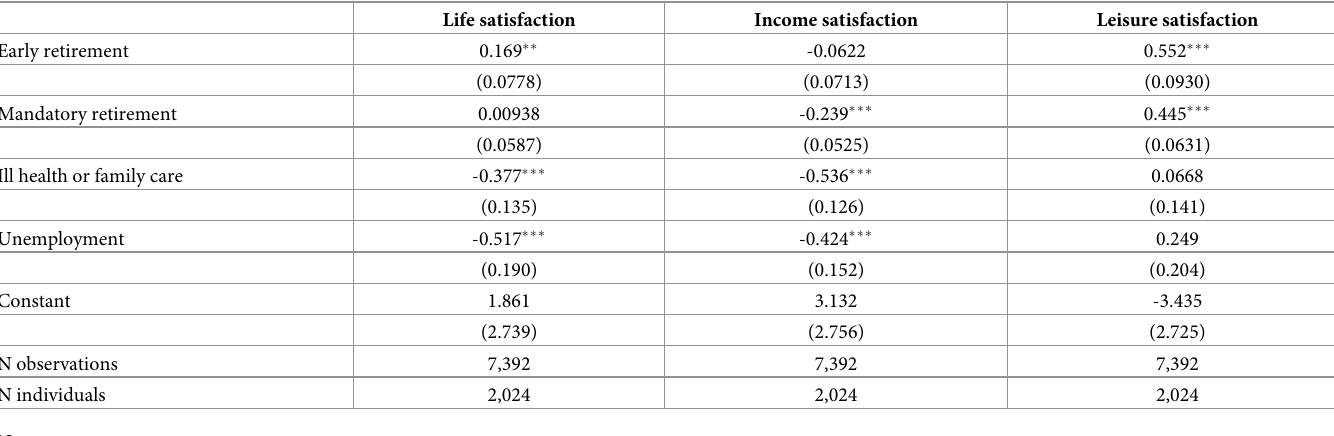
Table 2. Exit pathways and well-being.